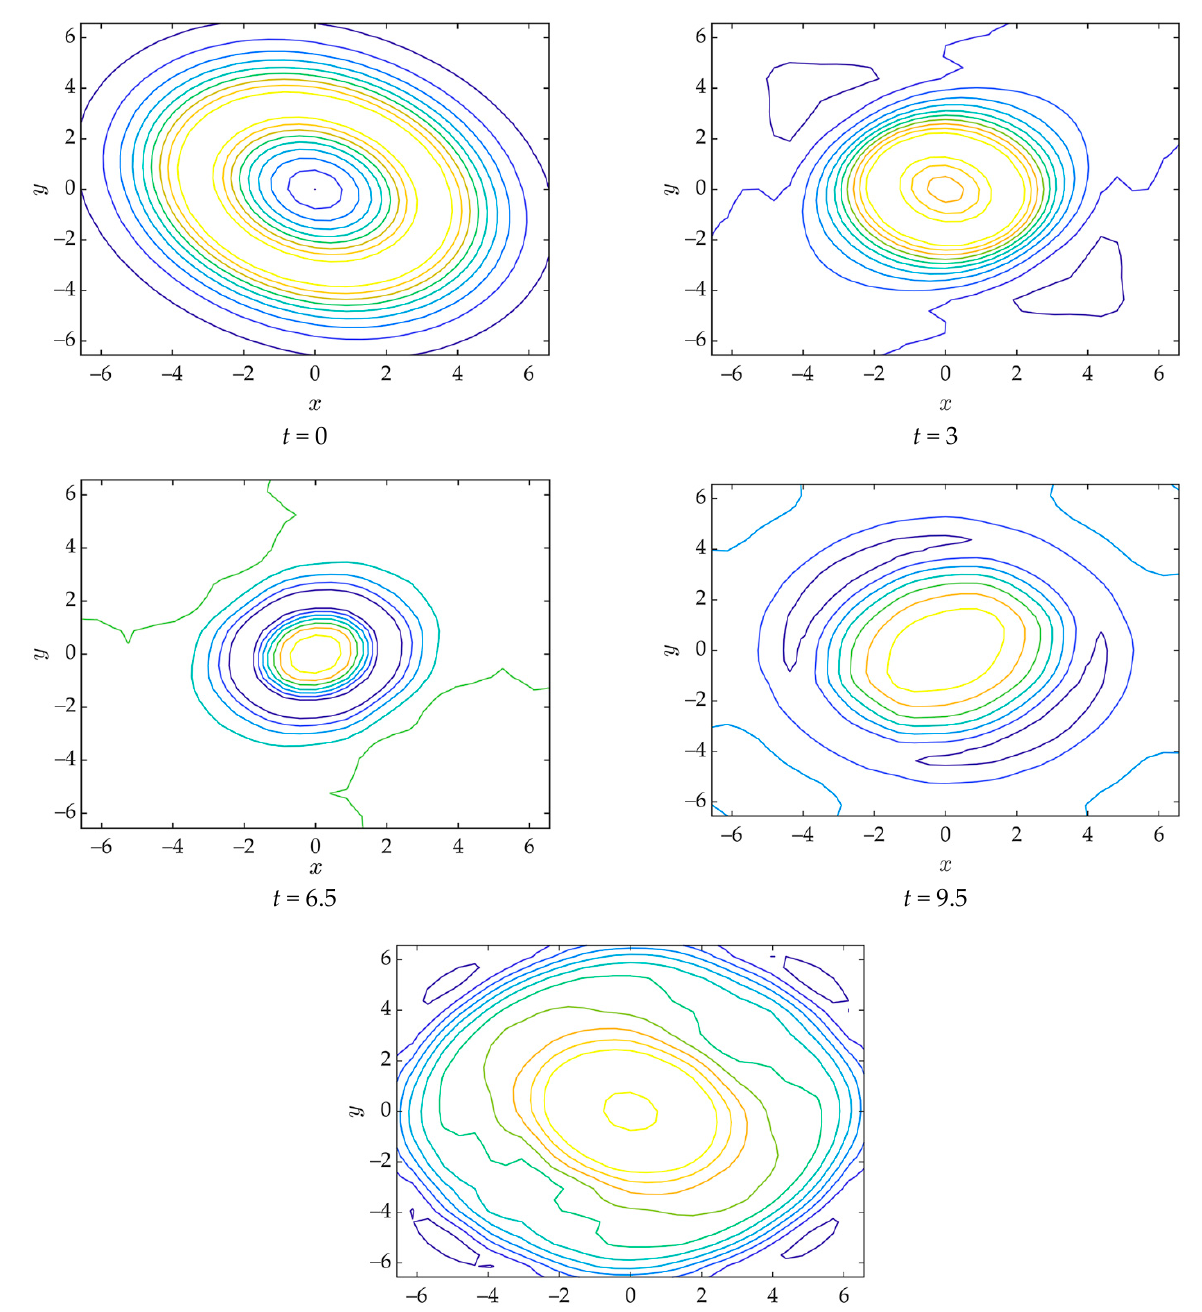
Figure 7. Contours of the elliptical ring soliton in( u /2) at different times for Case III of Example 3.